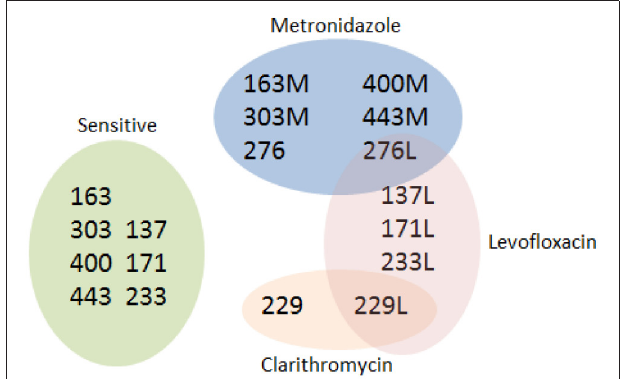
FIGURE 1 | H. pylori strains according to sensitivity or resistance to metronidazole a , levofloxacin, clarithromycin b , and combined (multi-drug c ) resistance. a UM276 and UM276L (levofloxacin-sensitive and resistant), UM163M, UM303M, UM400M, UM443M have naturally-occuring resistance to metronidazole. b UM229 and UM229L (levofloxacin-sensitive and resistant) has naturally-occuring resistance to clarithromycin. c Resistant to metronidazole, levofloxacin, and/or